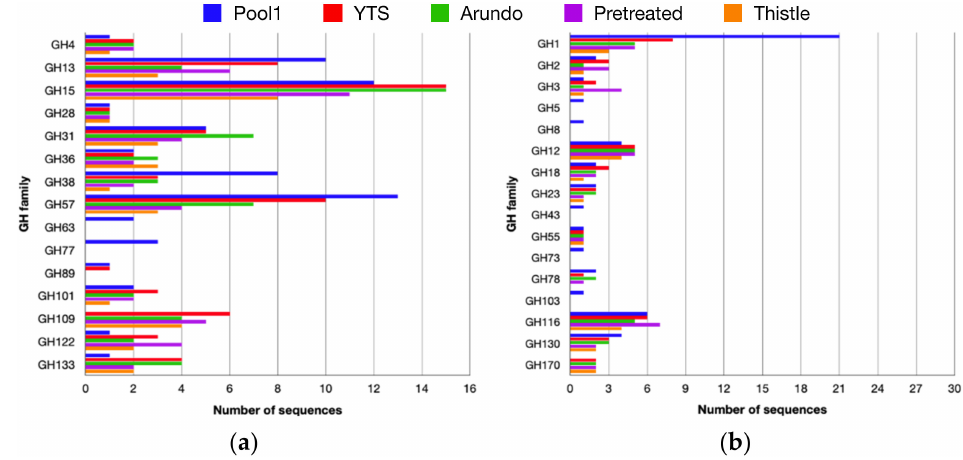
Figure 2. Distribution of the glycosidases active on axial ( a ) and equatorial ( b ) C1-OR